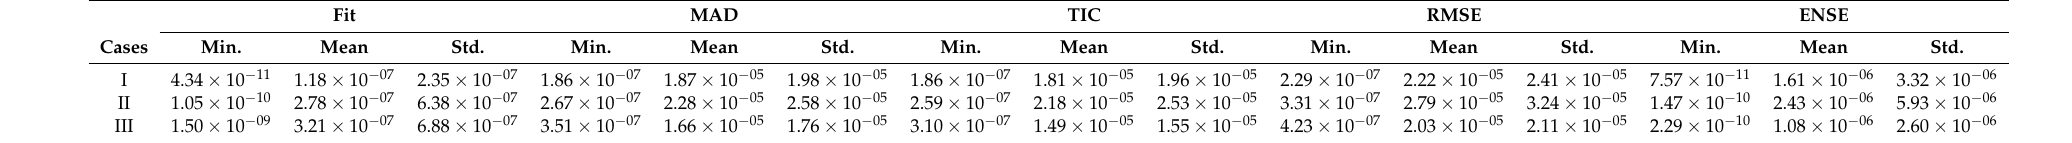
Table 13. Fitness values, MAD,TIC RMSE and ENSE for SCENARIO II of the drainage problem.